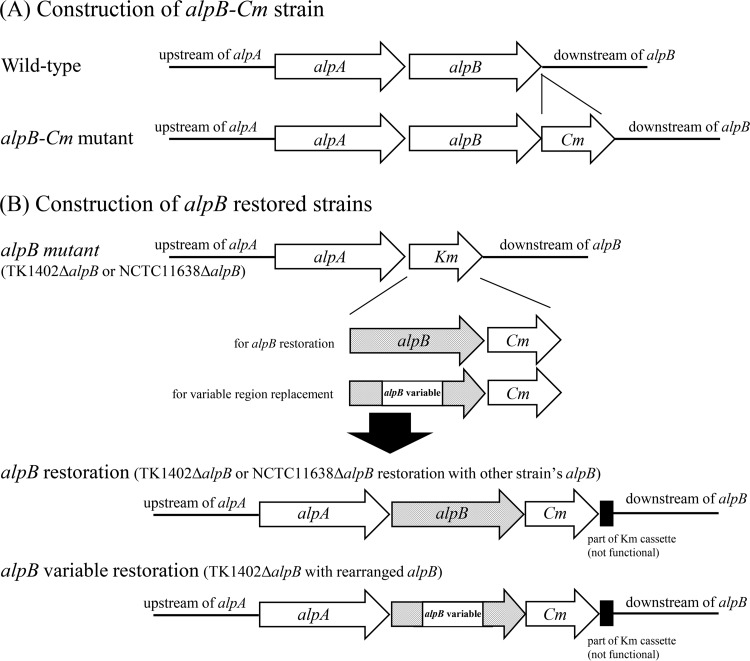
Schematic construction of the alpB-Cm mutant (A) and alpB restored (B) strains. All of the fragments were created with overlap extension PCR. These fragments were introduced into H. pylori strains by natural transformation.